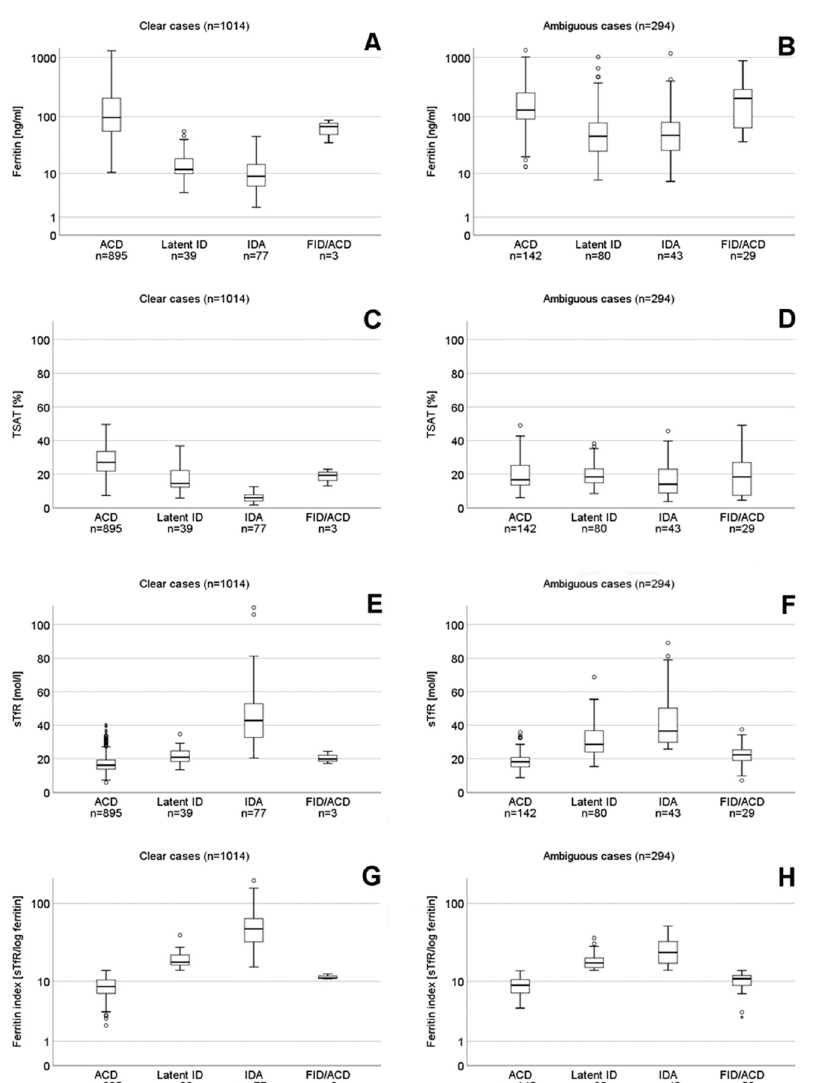
Figure 3: Box – Whisker plots representing the different values for ferritin, TSAT, sTfR, and ferritin index in the four anemia categories. Distinction between the clear cases (manual assignment and TP identical) (left panel: A, C, E, G) and the ambiguous cases (rightpanel:B,D,F,H).Theboxesrepresent the 25th and 75th percentiles, whiskers